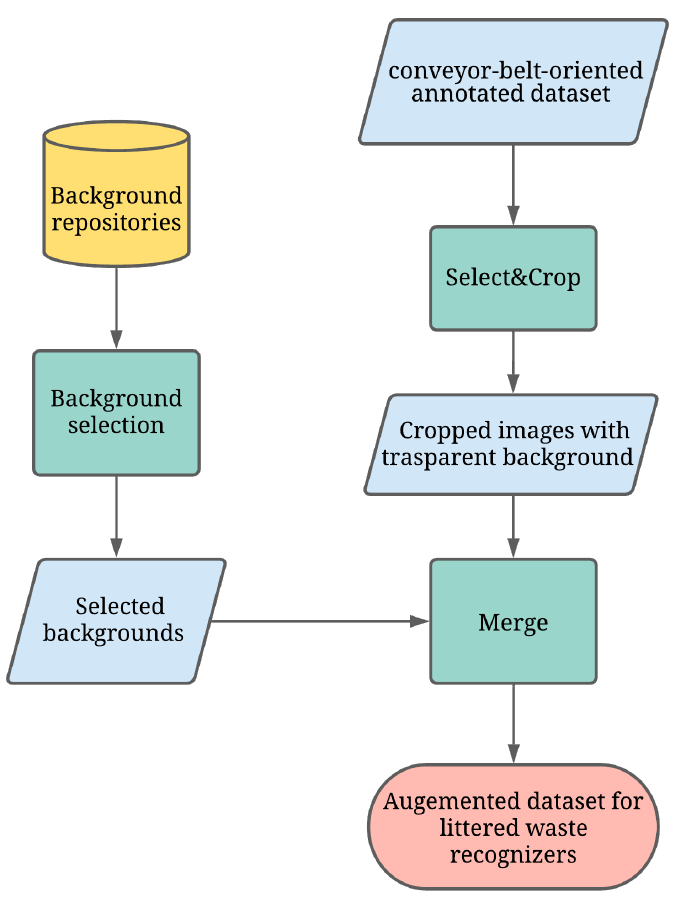
Figure 3. BackRep: a data-augmentation procedure based on image background